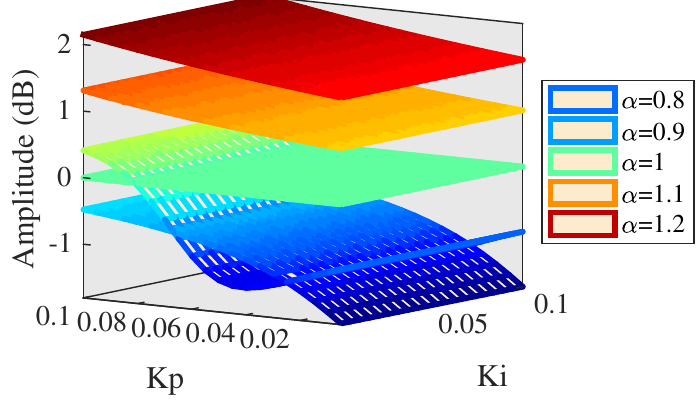
Figure 15. Amplitude of AMFC ( α = 0.8 to 1.2).